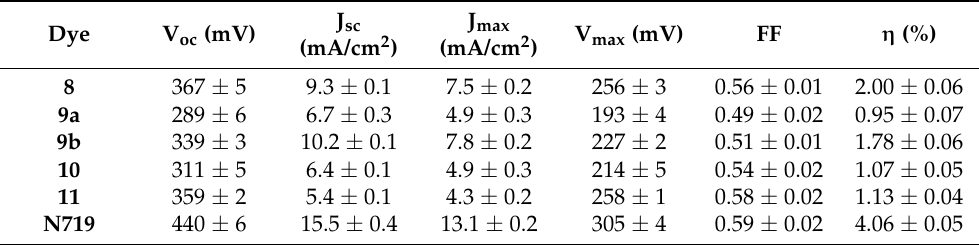
Figure 4. ( a ) I–V curves of the test cells based on the synthesized dyes under 100 mW · cm − 2 un- der simulated AM 1.5 illumination. The results presented correspond to the best performing cell. ( b ) Pictures of the dyes adsorbed on the TiO 2 photoanodes. Table 4. Performance values of the test cells based on the synthesized dyes and reference dye N719 under 100 mW · cm − 2 AM 1.5 illumination. The results presented correspond to the average values of at least two cells per dye, each cell measured 5